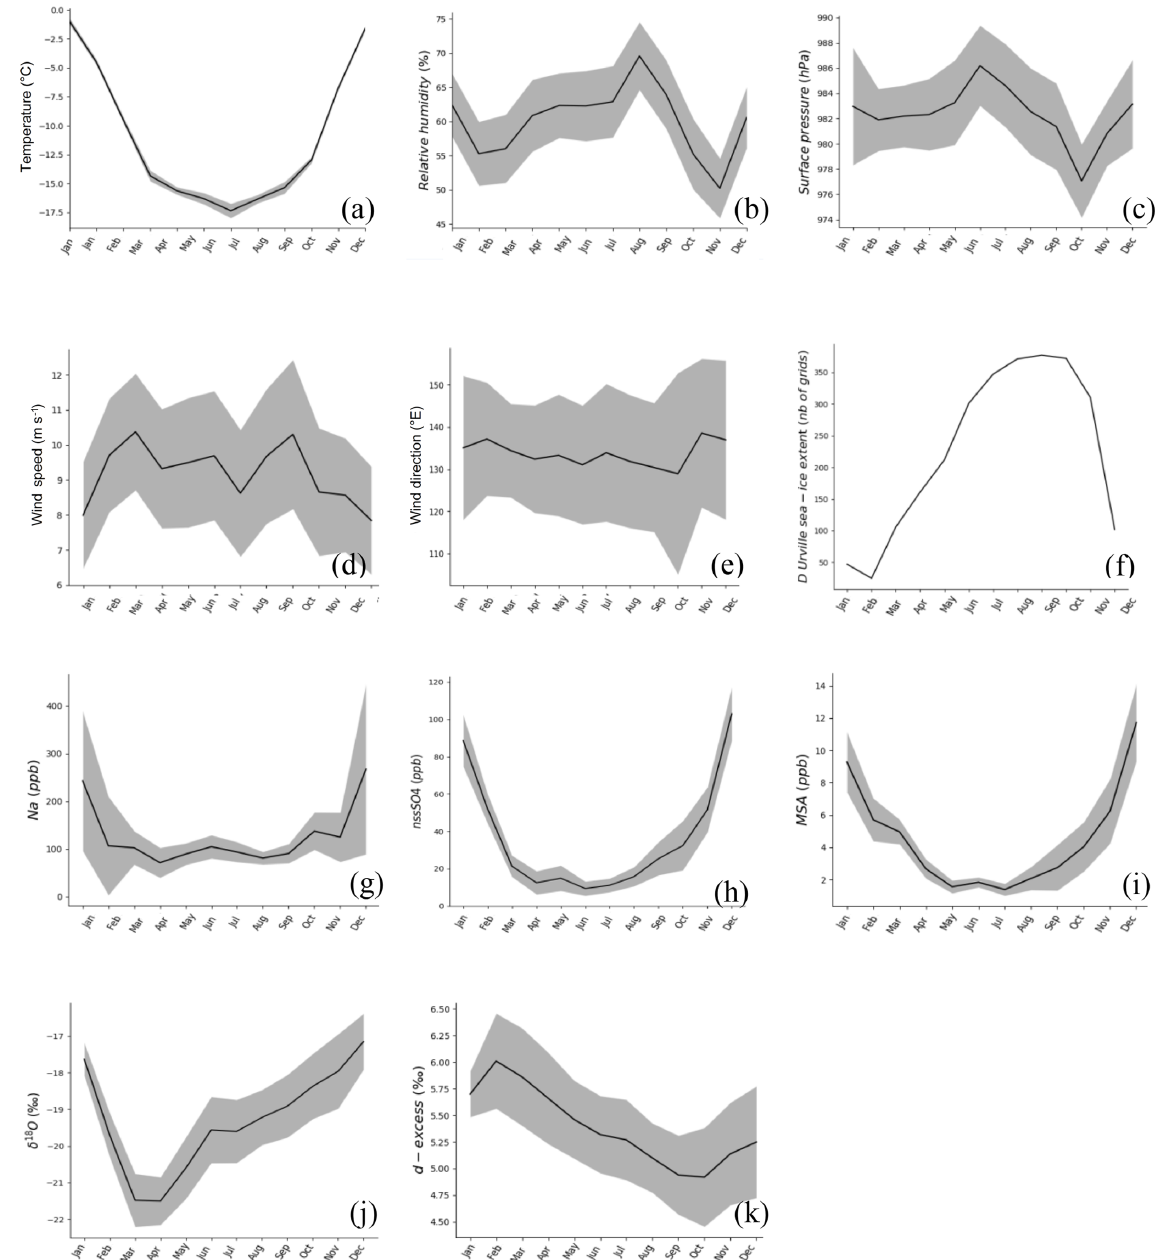
Figure 8. Mean seasonal cycles over the period 1998–2014. Meteorological observations are averaged from daily data, for near-surface temperature ( a , ◦ C), relative humidity ( b , i%), surface pressure ( c , hPa), wind speed ( d , ms − 1 ), wind direction ( e , ◦ E), and local sea ice concentration, i.e. averaged over a 135–145 ◦ E ridge ( f , %). Seasonal cycles from ice core records are averaged from the resampled time series for Na ( g , ppb), nssSO 4 ( h , ppb), MSA ( i , ppb), δ 18 O ( j , ‰), and d -excess ( k , ‰). The inter-annual standard deviation is highlighted with the grey